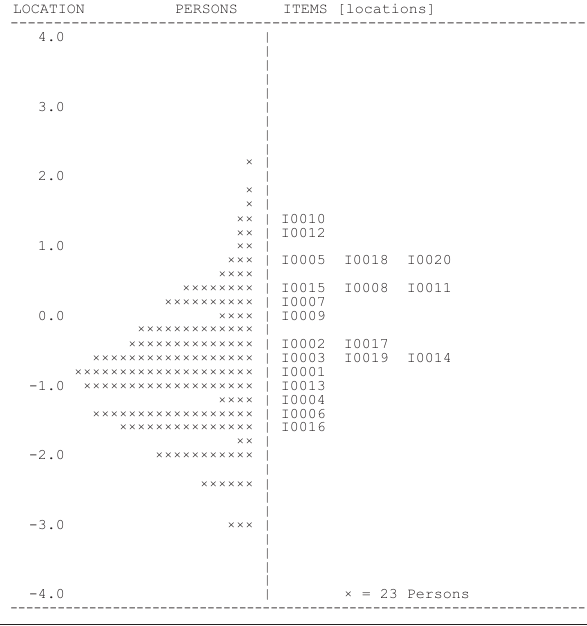
FIGURE 3: Person-item map for MM data with mean item location at zero. FIGURE 2: Person-item map for ZM data with mean item location at zero.